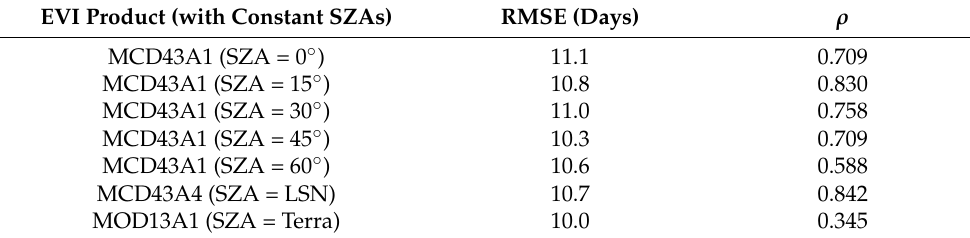
Table 3. Difference between the ground-observed and EVI-derived SOS.